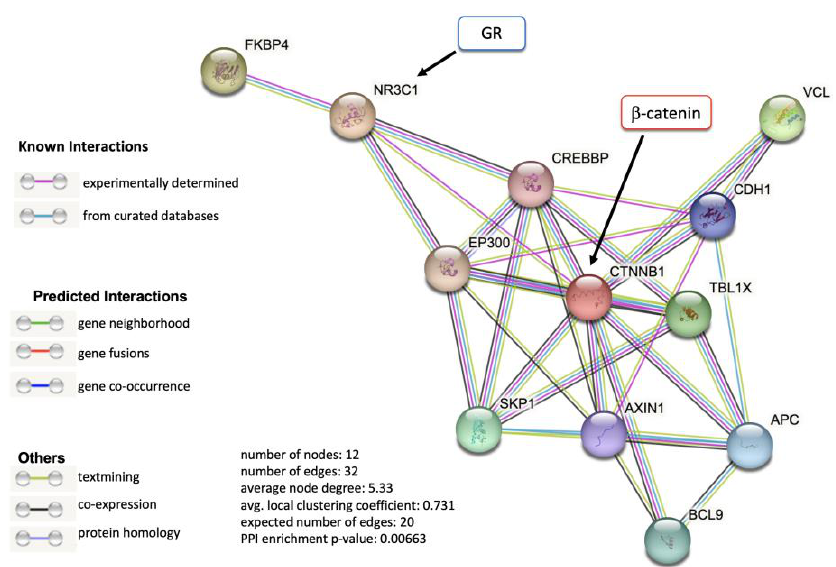
Figure 6. GR and β -catenin interaction module detected by STRING analysis. GR is encoded by the NR3C1 gene and β -catenin by the CTNNB1 gene. The only GR/ β -catenin interactions detected in this analysis were from gene fusion (red line) and text mining (light green).